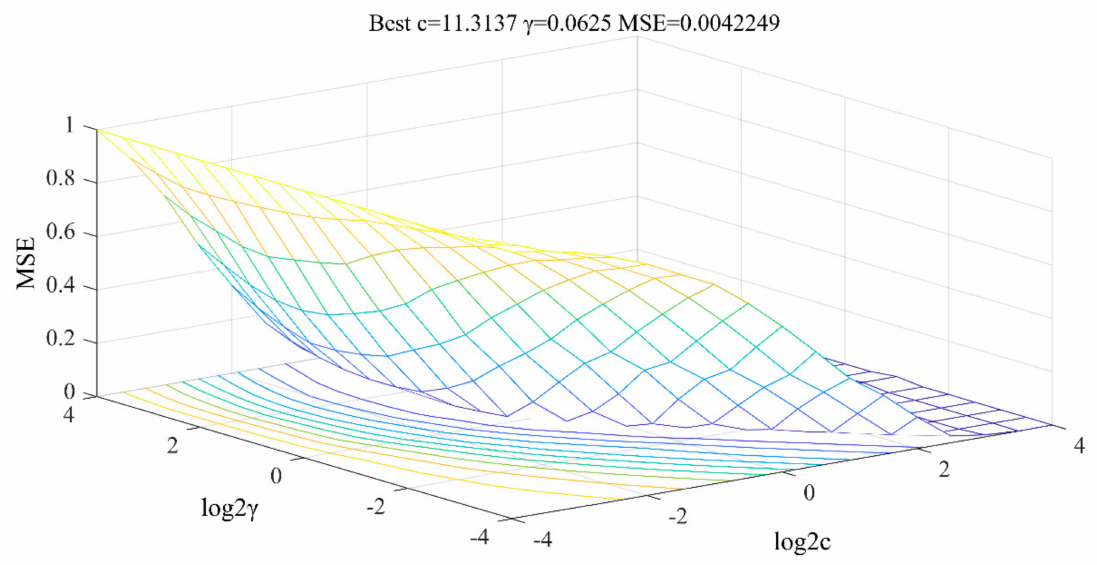
Figure 9. A 3D contour map for parameter determination for the three-factor SVRM model using the grid-search method.